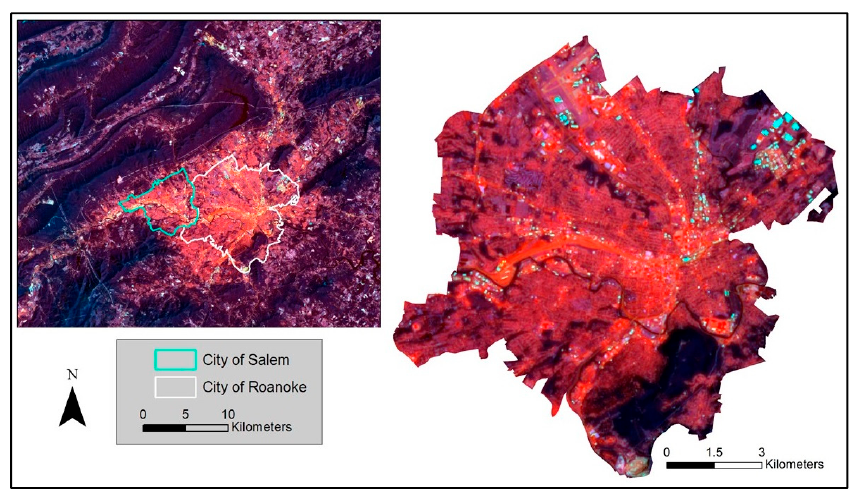
Figure 2. Landsat 8 thermal image (bands 10-7-6) of a portion of southwest Virginia ( left ) and zoomed into the City of Roanoke ( right ). Image acquired 24 May 2014 at 10:58 a.m. EST, illustrating urban heat island—urban to rural differences ( left ), and internal variations within the city ( right ). Darker areas are much cooler; much warmer areas are very bright red (roadways) and very bright cyan areas (building roofs).